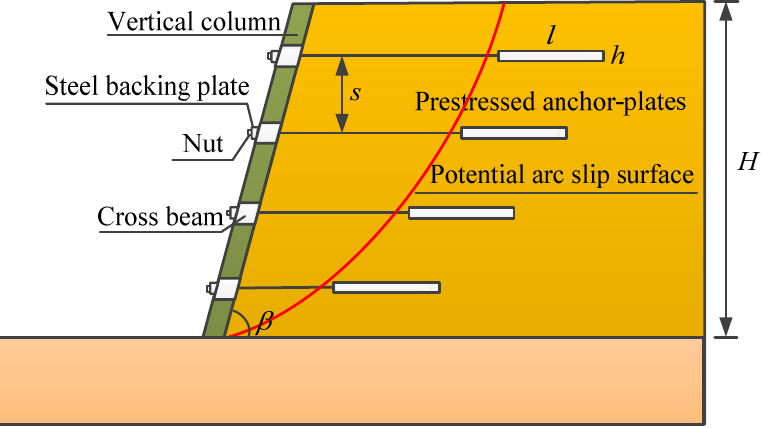
Figure 4. Section view of a frame with a prestressed anchor-plate supporting structure.